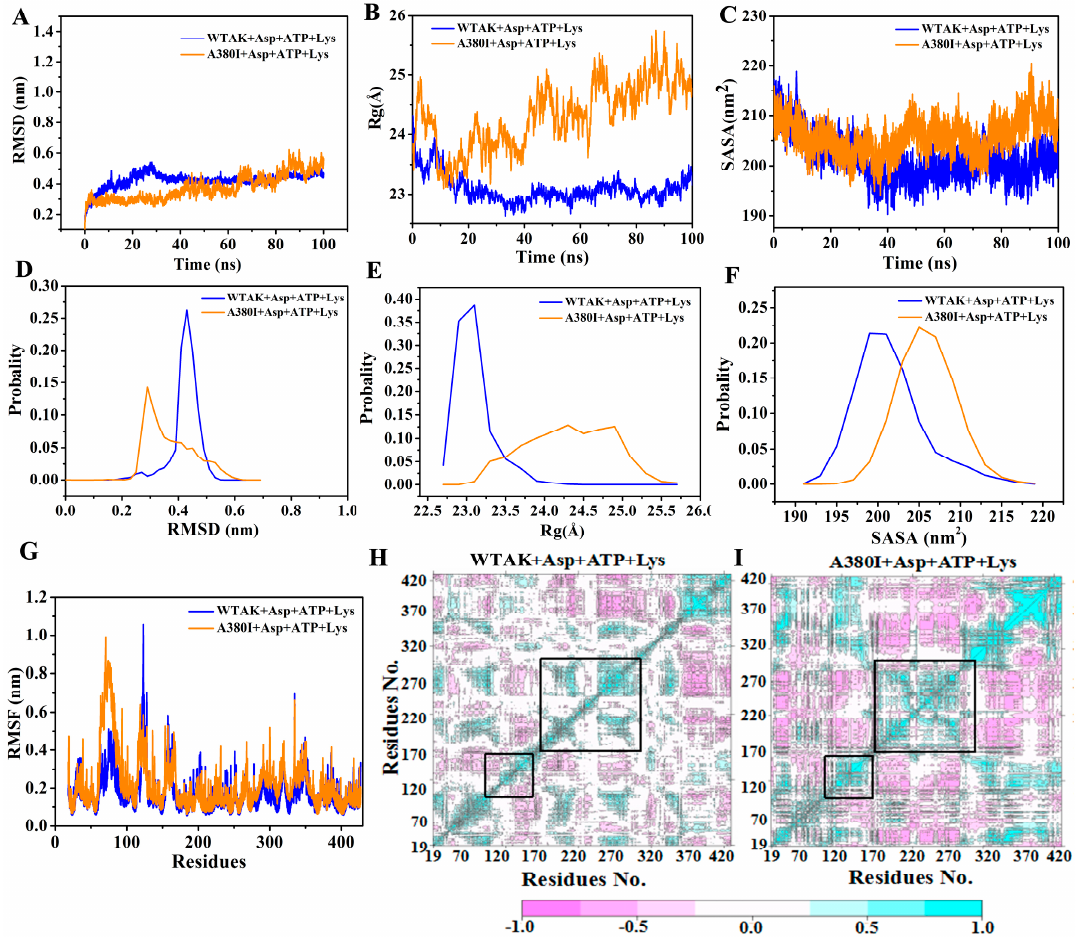
Figure 4. ( A ) RMSD plot during 100 ns MD simulations. Blue represents WT-AK + Asp + ATP + Lys and orange represents A380I + Asp + ATP + Lys, the same below. ( B ) Rg plot. ( C ) SASA plot. ( D ) The probability of RMSD of two complexes (WT-AK + Asp + ATP + Lys and A380I + Asp + ATP + Lys). ( E ) The probability of Rg. ( F ) The probability of SASA. ( G ) RMSF plot. ( H ) Domain cross correlation analysis performed on all C α atom pairs of WT-AK with Asp, ATP and Lys. ( I ) Domain cross correlation analysis performed on all C α atom pairs of A380I with Asp, ATP and Lys. The positive correlation region marked in the cyan indicated the strong correlated movement of the residue. The negative correlation region marked in the pink indicated anti-correlation movement of the residue. The diagonal was related to the relative height, representing the variance of the residue with itself.